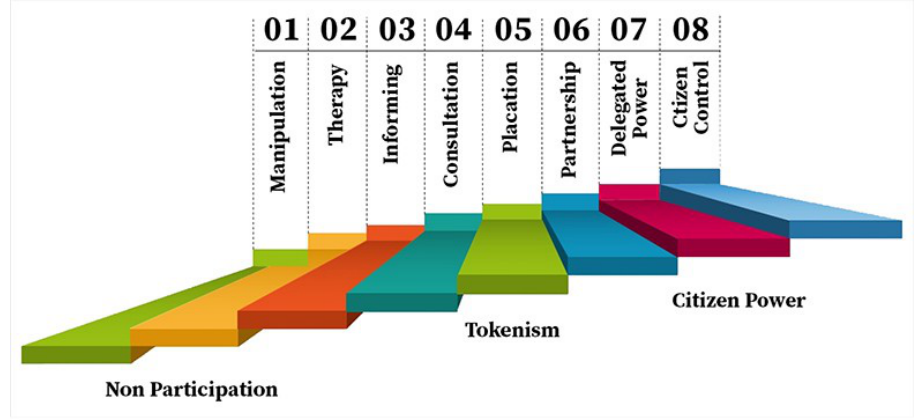
Figure 2. Arnstein’s Ladder of Participation.